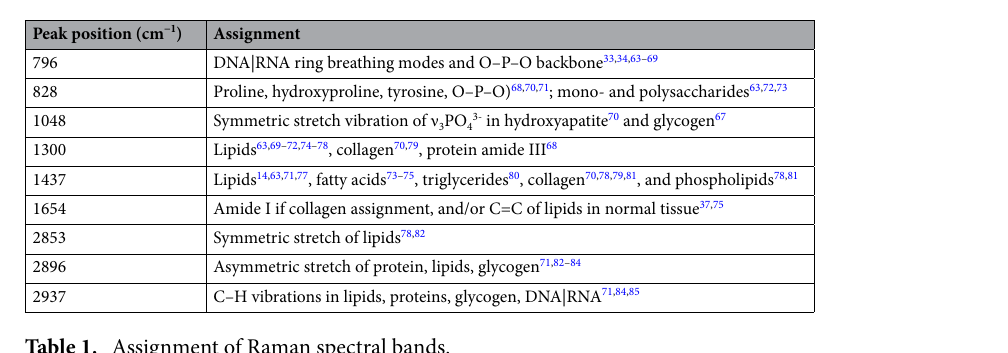
Table 1. Assignment of Raman spectral